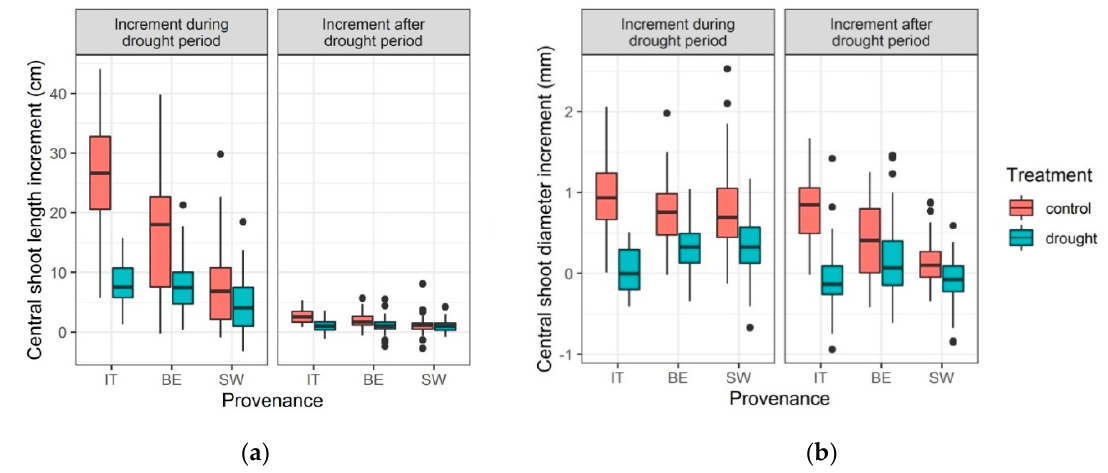
Figure 6. Growth increments for length and diameter of the central shoot during and after the water withholding treatment in 2018. ( a ) Box plots of the lengths of the central shoot; ( b ) Box plots of the diameters of the central shoot. IT: Italian provenance, BE: Belgian provenance, SW: Swedish